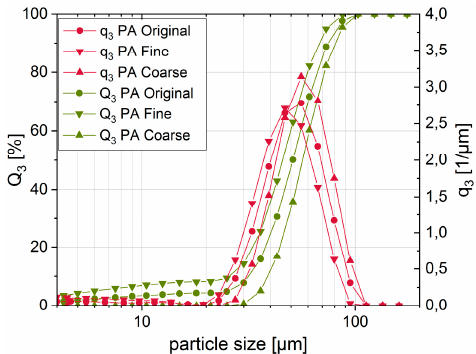
Figure 5. Cumulative fraction Q 3 and density distribution q 3 of particle size distributions (PSD) of PA by dynamic laser diffraction.